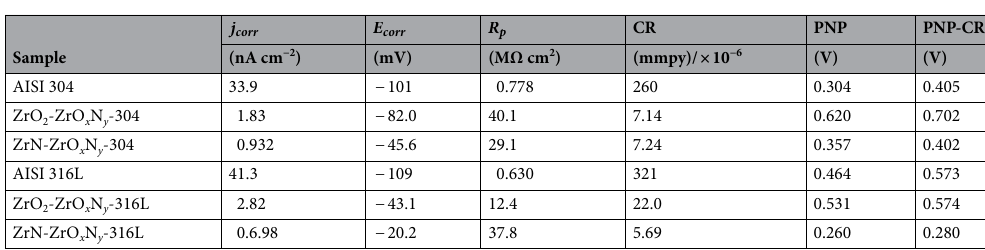
Table 3. Values average of the parameters of the corrosion test. j corr = corrosion current density; E corr = corrosion potential; R p = polarization resistance; CR = corrosion rate; mmpy = millimeters per year; PNP = pitting nucleation